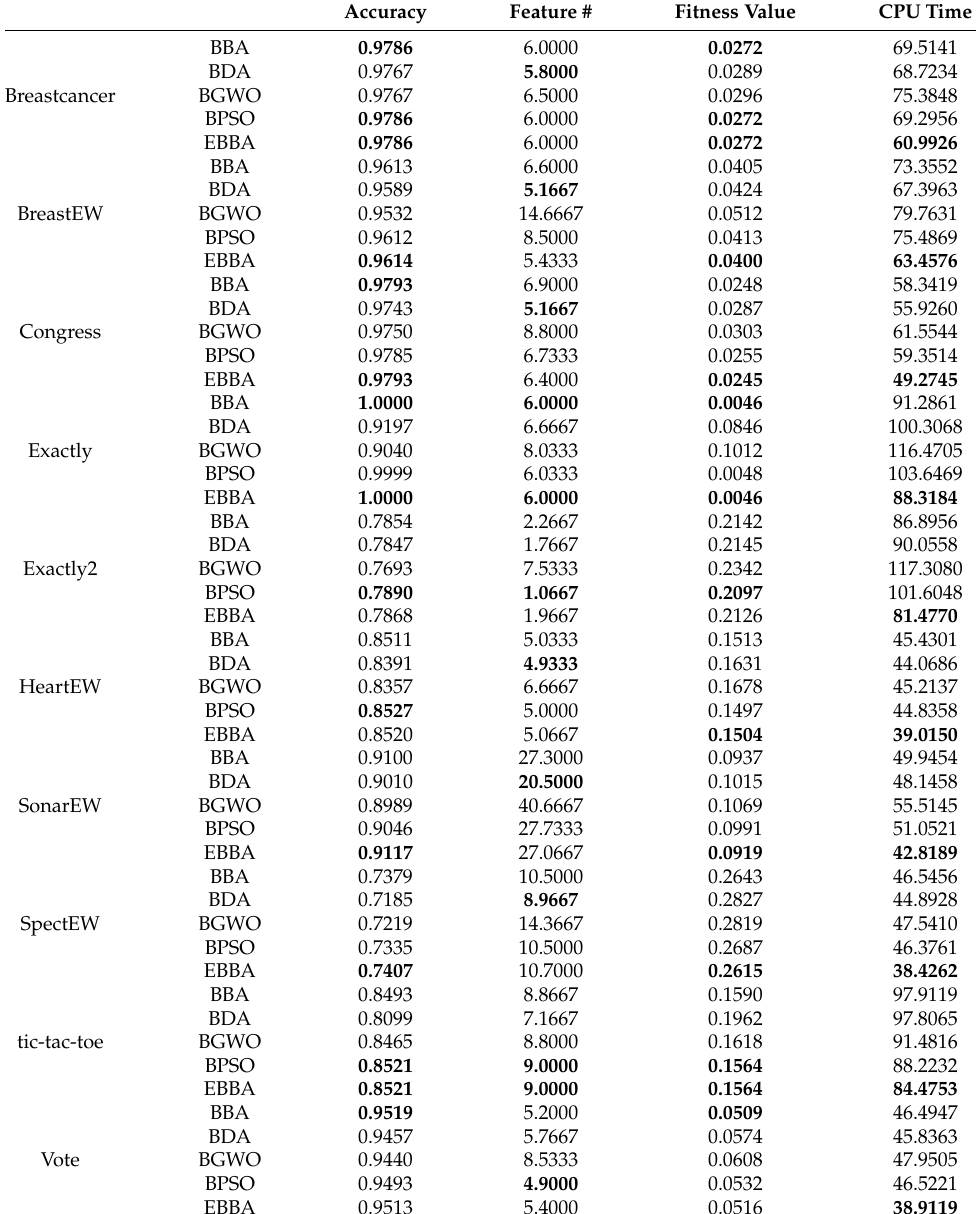
Table 3. Optimization results achieved by various algorithms. (The best values are highlighted in